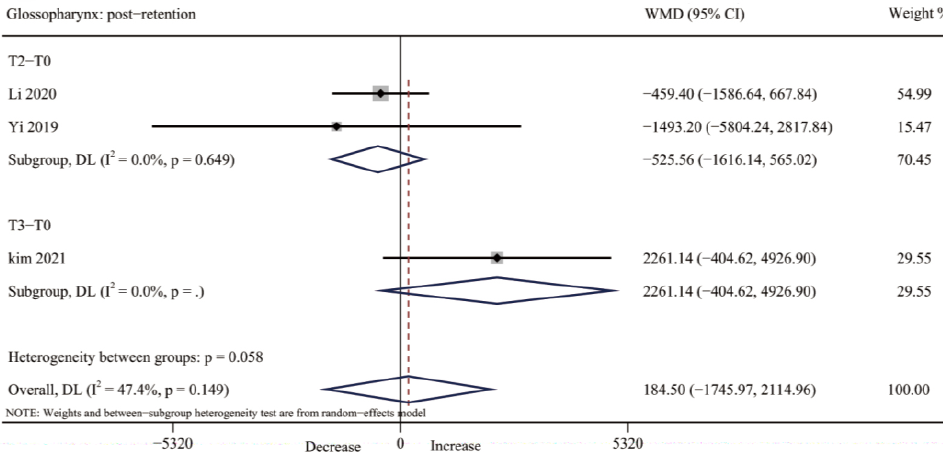
Figure 8. Forest plot for the changes of glossopharynx volume after retention (T2-T3). T0, before expansion; T2, three months after expansion; T3, six months after expansion; WMD, weighted mean difference; CI, confidence interval [32,34,35].